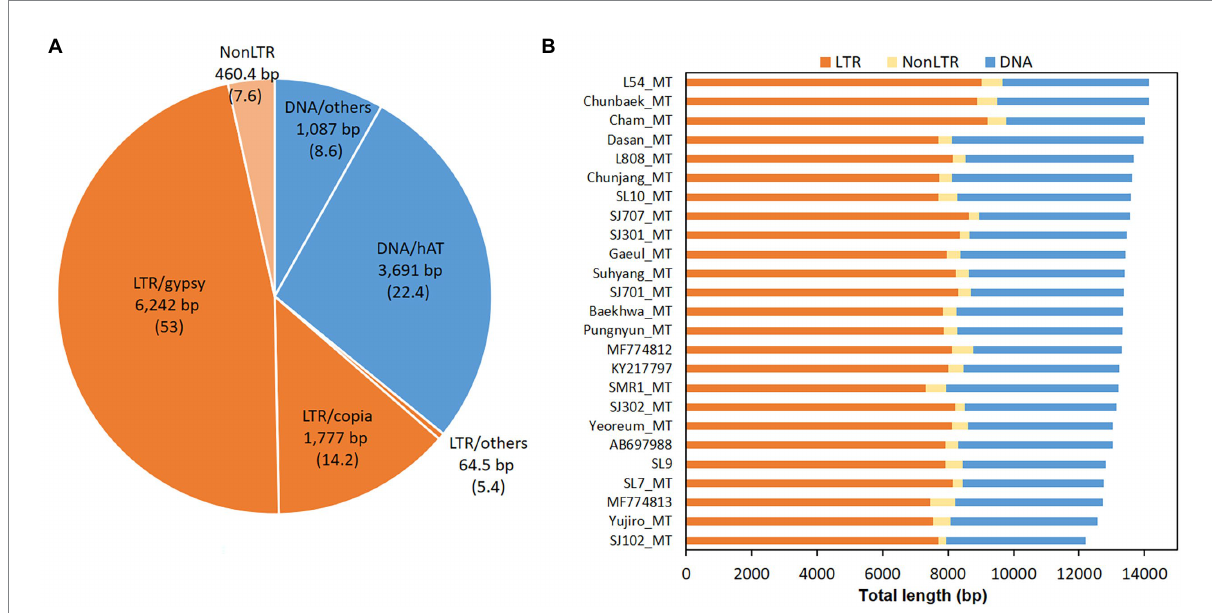
FIGURE 7 Transposable elements (TEs) in the mtDNA of L. edodes . TEs in 25 mtDNAs were predicted by Censor program. (A) Average contents of TEs. Retrotransposons are orange-colored while DNA transposons are in blue. Average number of each TE is described in parenthesis. (B) Total length of TEs in different